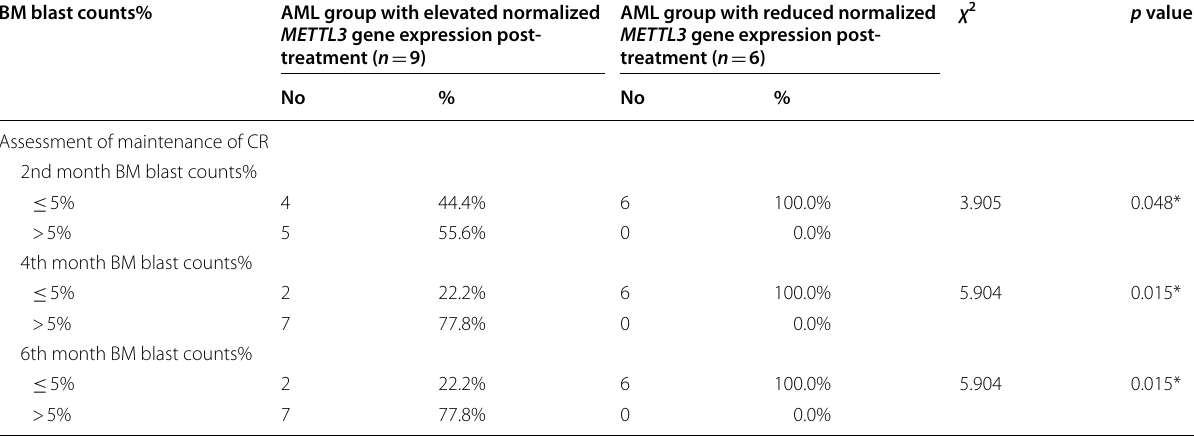
Table 7 Comparison between patients with elevated post‑treatment METTL3 gene expression versus patients with lowered post‑ treatment gene levels regarding BM blast counts in follow‑up samples